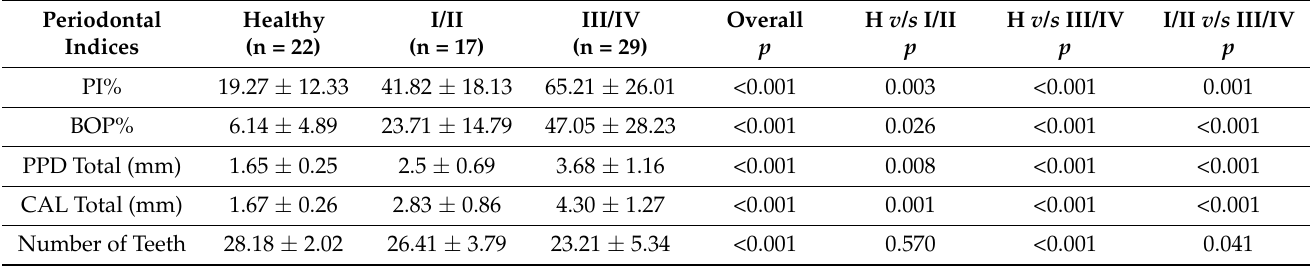
Table 2. Periodontal indices in periodontally healthy and periodontitis I/II and III/IV patients.